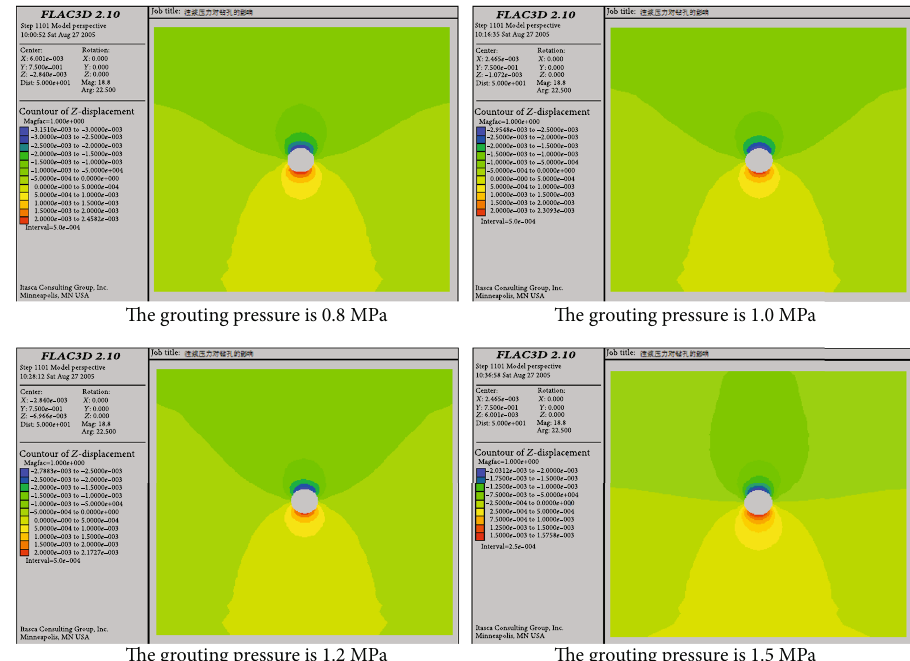
Figure 4: Displacement distribution in the Z